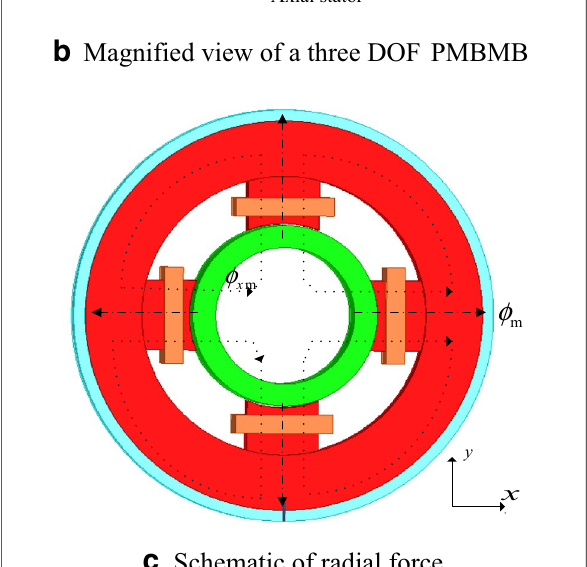
Figure 2 Schematics of a three DOF